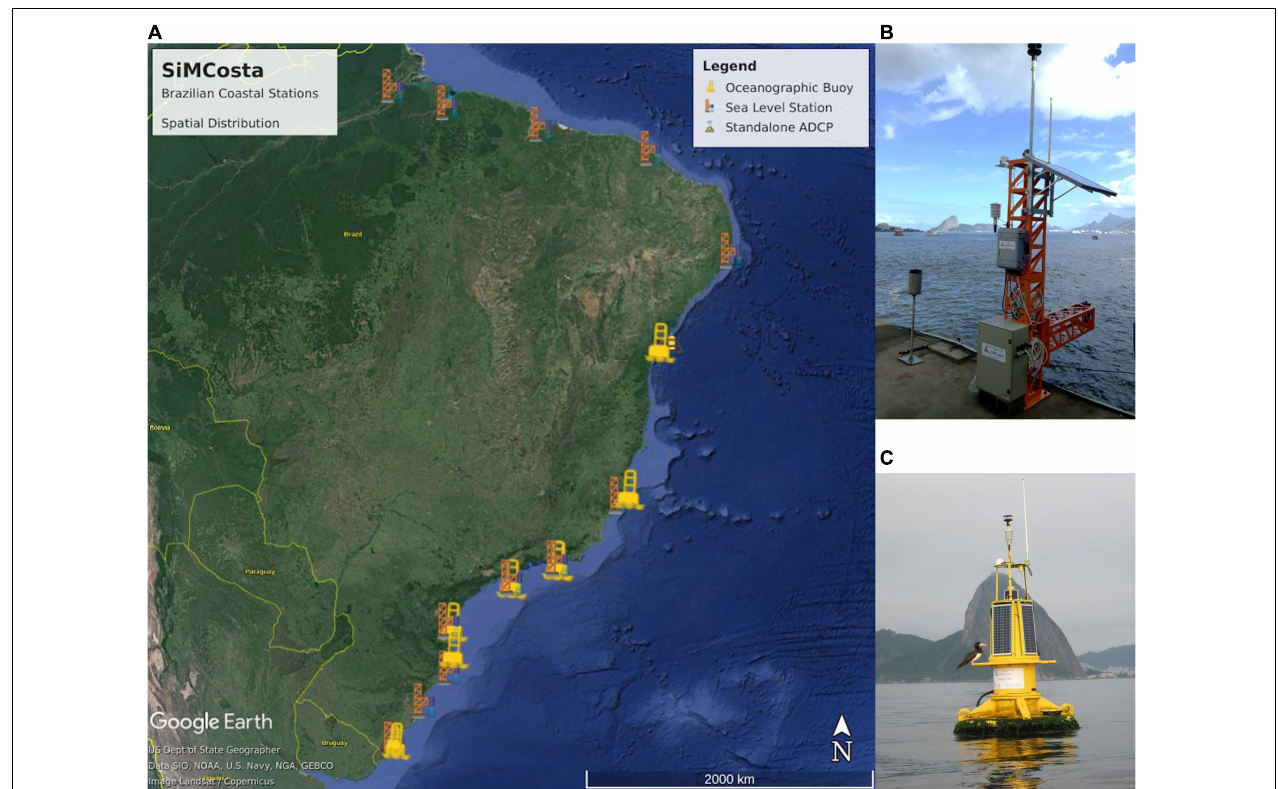
FIGURE 1 | (A) The map spatial distribution of SiMCosta sea level stations and moored coastal buoys. (B) Example of SiMCosta sea level station and (C) moored coastal buoy. Data can be downloaded via